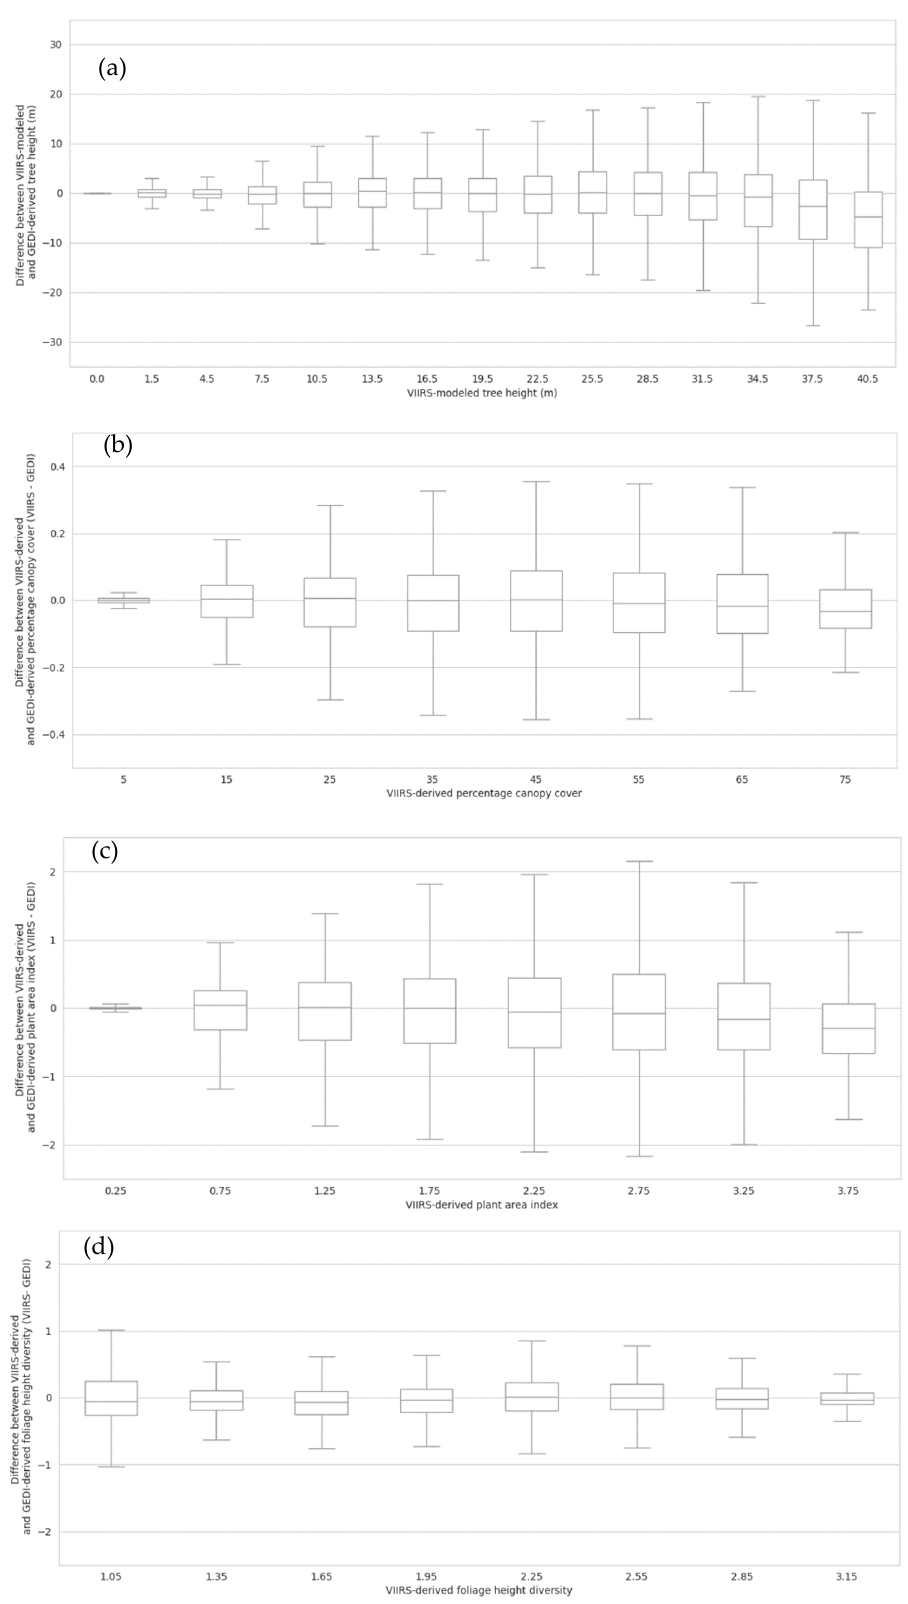
Figure 6. Distribution of differences between ( a ) VIIRS and GEDI-derived canopy height; ( b ) VIIRS and GEDI-derived fraction cover, ( c ) VIIRS and GEDI-derived Plant Area Index; and ( d ) VIIRS and GEDI-derived foliage height diversity.